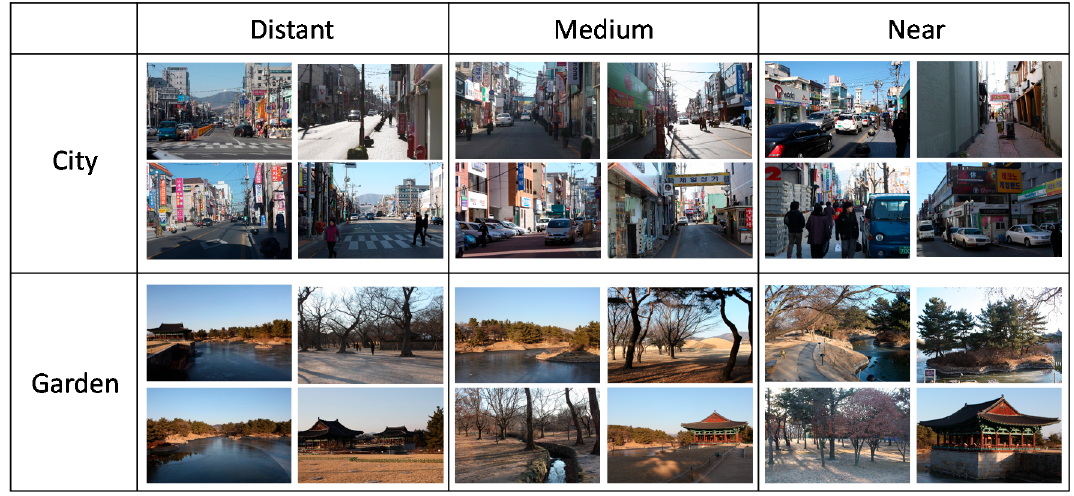
Figure 1. Landscape images of city and garden used in the experiment.